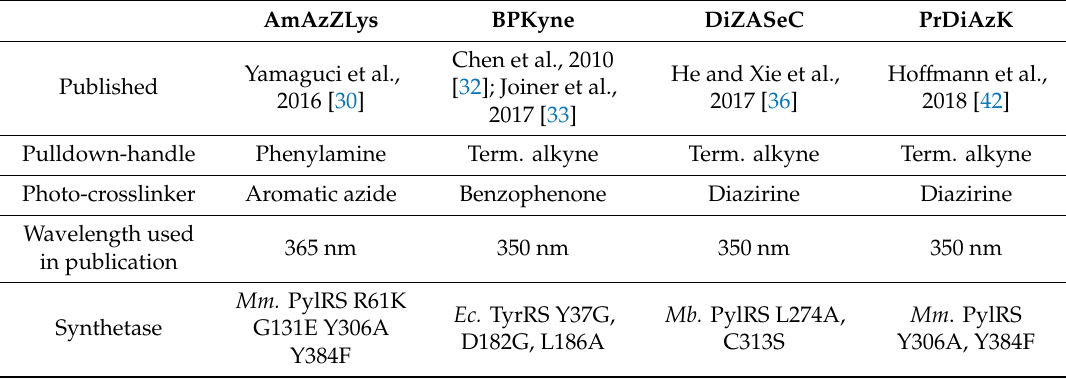
Table 1. Comparison and properties of four di ff erent bifunctional